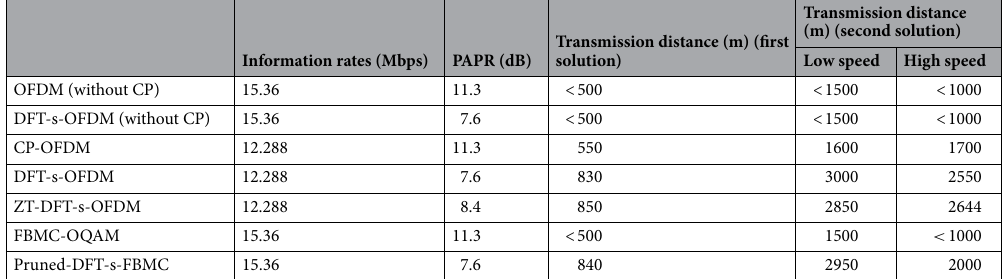
Table 3. Performance comparison between various multi-carrier